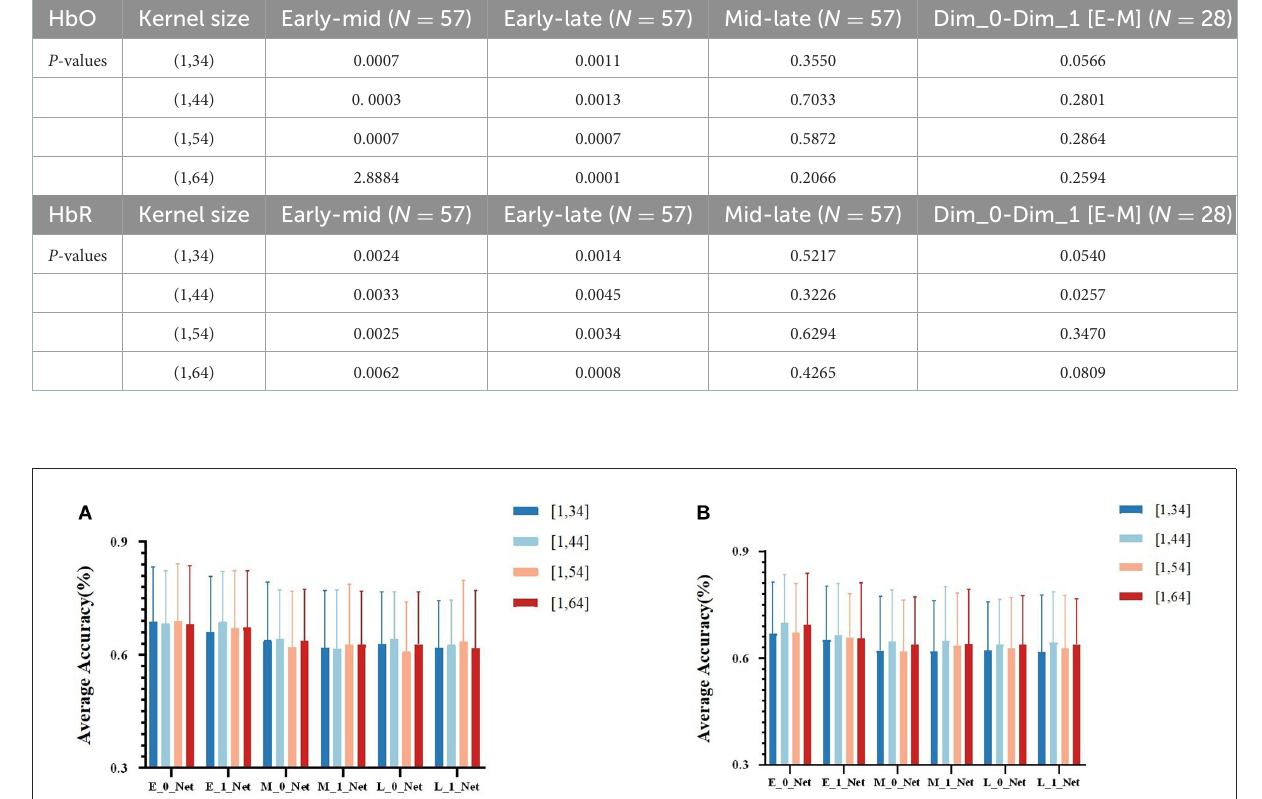
FIGURE7 (A) The average classification accuracy of all participants using EEG-HbO in different fusion strategies. (B) The average classification accuracy of all participants using EEG-HbR in different fusion